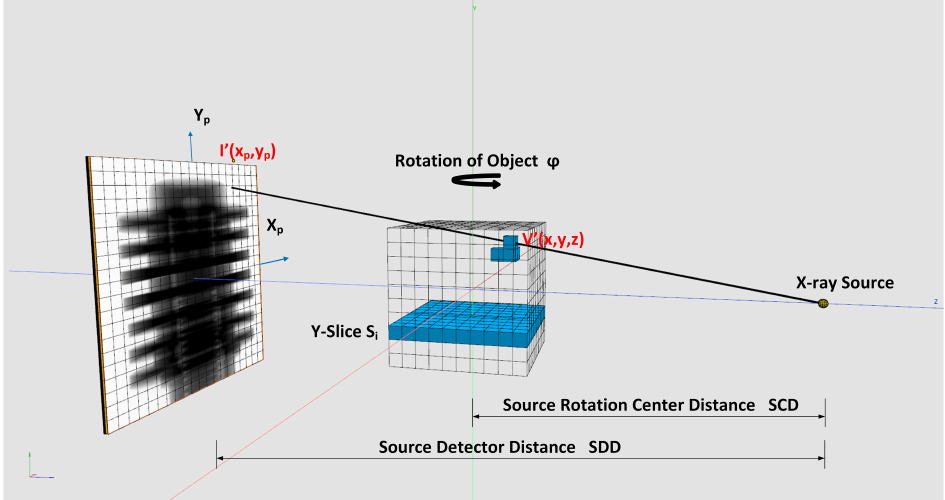
Figure 5. Voxel-driven